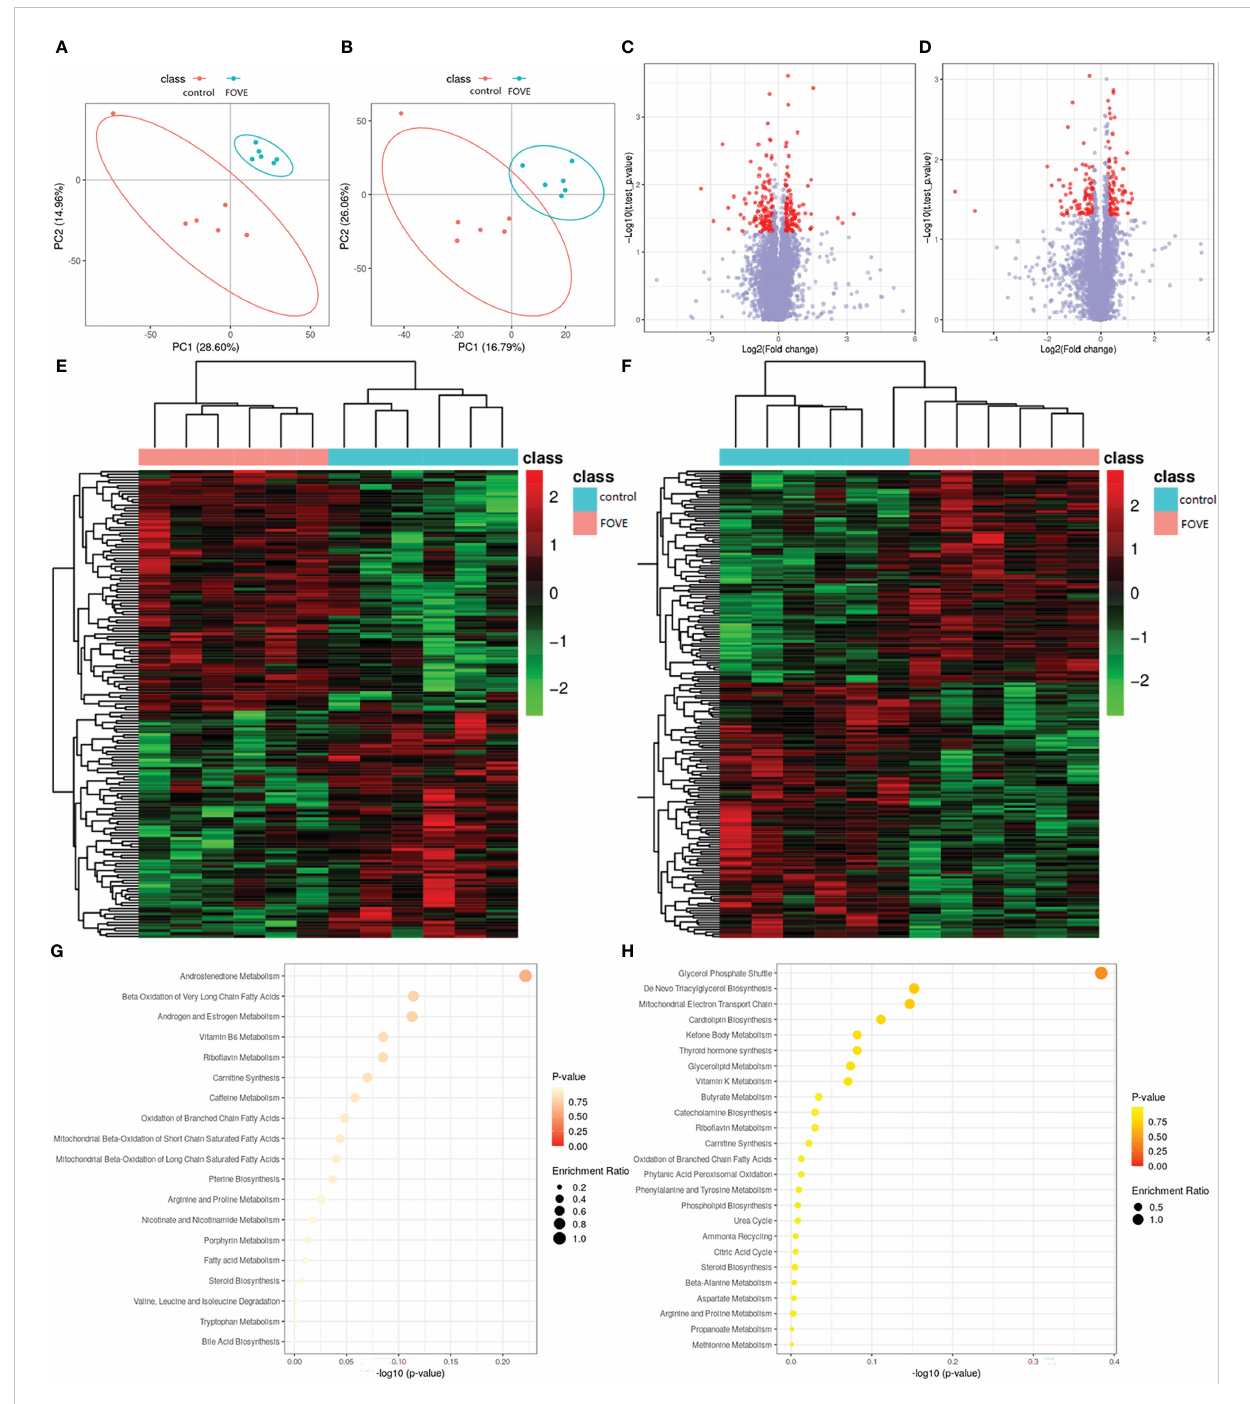
FIGURE 5 Seminal plasma metabolomic changes and pathway enrichment. Positive ion mode (A) and negative ion mode (B) for the partial least square- discriminate analysis (PLS-DA) score charts of metabolite pro fi ling data. Analysis of the fl axseed oil + vitamin E (FOVE) group and control group based on metabolomics. Volcano fi gure under positive ion mode (C) and negative ion mode (D) , with the red points representing different levels of metabolites. Hierarchical clustering analysis of positive ion mode (E) and negative ion mode (F) , with red denoting increased expression and blue denoting decreased expression. The pathway analysis for positive ion mode (G) and negative ion mode (H) . Colors (varying from yellow to red) show metabolites in the data with different levels of signi fi cance. The x-axis represents the pathway impact value computed from pathway topological analysis, and the y-axis is the-log of the P -value obtained from pathway enrichment analysis. The pathways that were most signi fi cantly changed are characterized by both a high-log ( P ) value and high impact value (top right